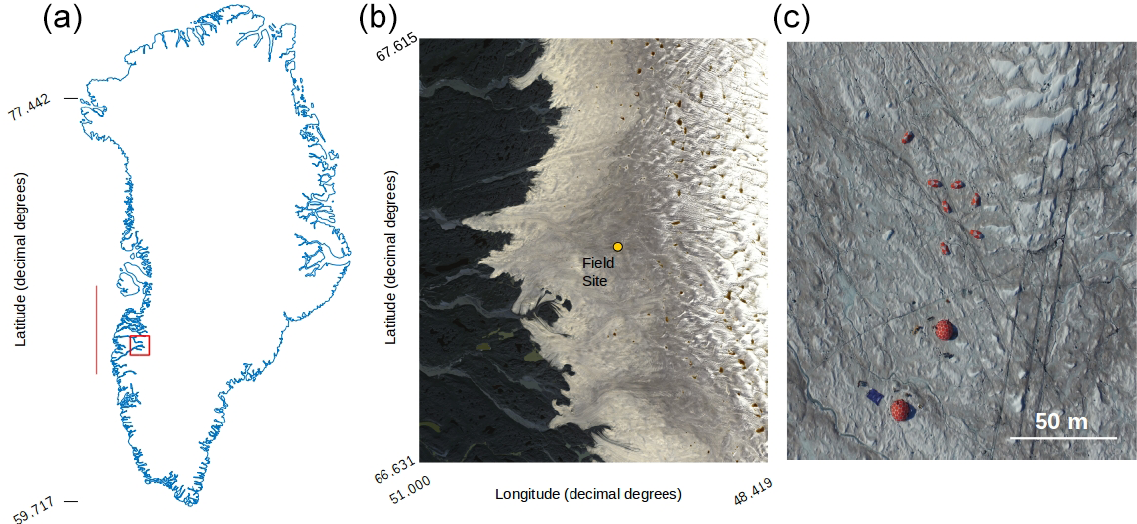
Figure 1. (a) Map of Greenland showing the bounding box of the Sentinel-2 tile (22WEV) containing our field site (red box) and the latitudinal extent of our runoff modelling (red line). The basemap was created using the MATLAB Arctic Mapping Toolbox (Greene et al., 2017). The Sentinel-2 tile outlined by the red box is shown in detail in (b) with the field site marked with a yellow dot. Sentinel-2 bands 2, 3 and 4 were combined into a true-colour composite using GDAL (geographical data abstraction library, 2019), by the lead author. Panel (c) shows the area immediately surrounding the field camp as captured by a DJI Phantom Pro by the lead